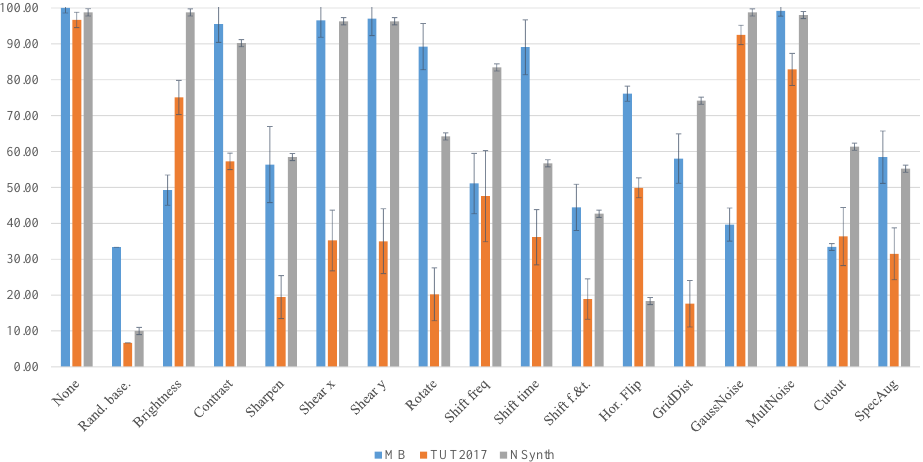
Figure 3. Mean accuracy and standard deviation for all augmentation methods on 5% of the labeled training data of each